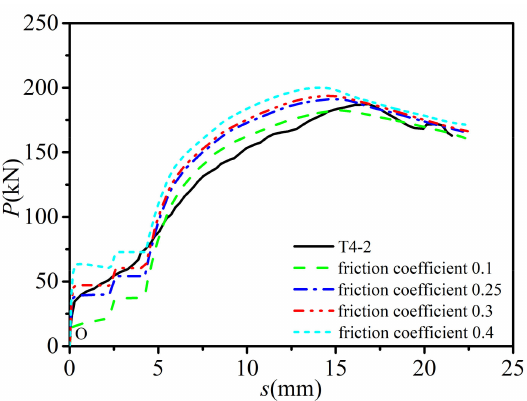
Figure 5. Load–slip relationship of T4-2 specimen for different contact friction